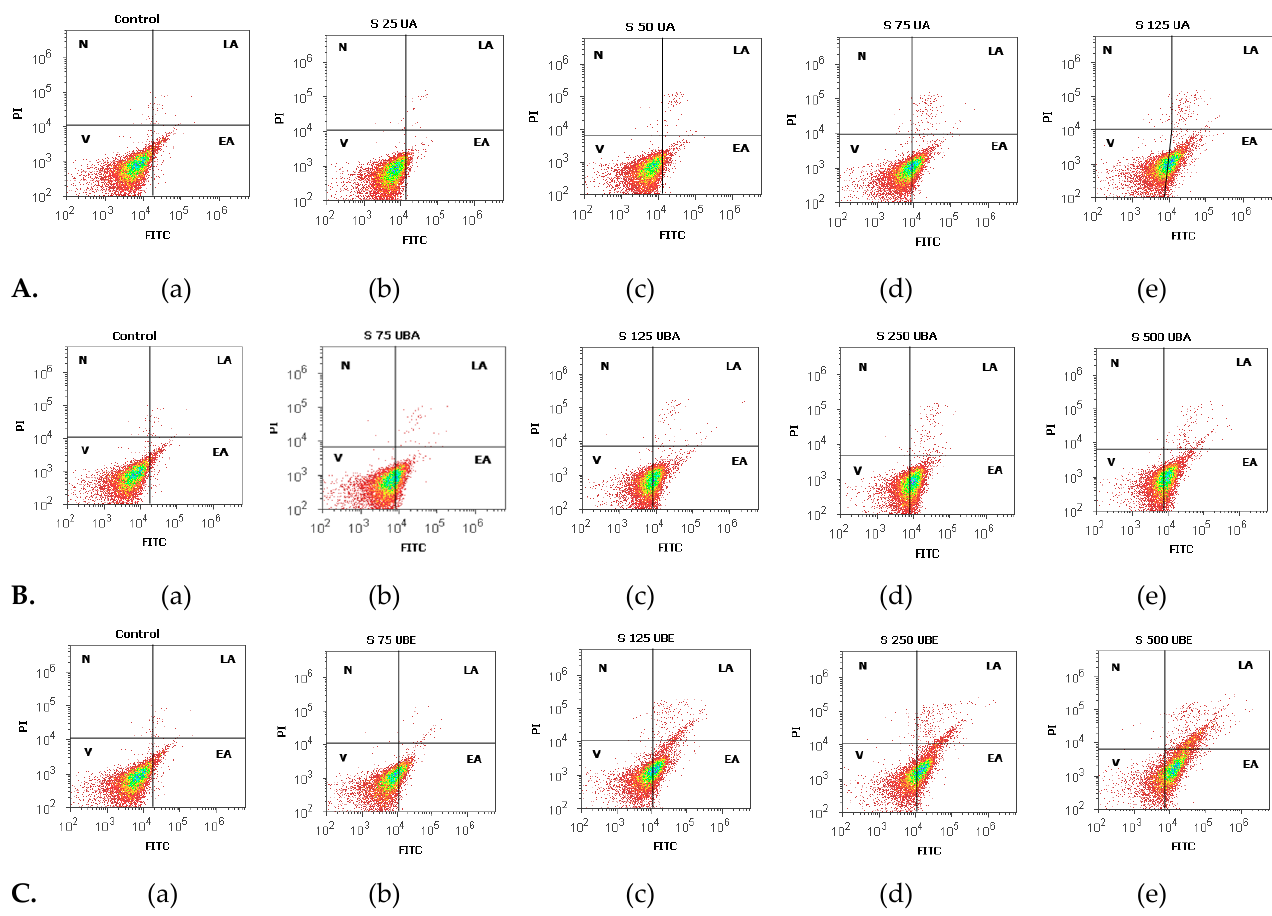
Figure 2. Cell apoptosis models of usnic acid (UA), U. barbata acetone (UBA), and U. barbata ethanol (UBE) treatments in normal blood cell cultures. Annexin V-FITC/PI patterns of 1% dimethyl sulfoxide (DMSO) Negative Control ( A ( a ), B ( a ), C ( a )); A ( b – e ) UA 25, 50, 75, 125 μ g/mL; B ( b – e ) UBA 75, 125, 250, 500 μ g/mL; and C ( b – e ) UBE 75, 125, 250, 500 μ g/mL.